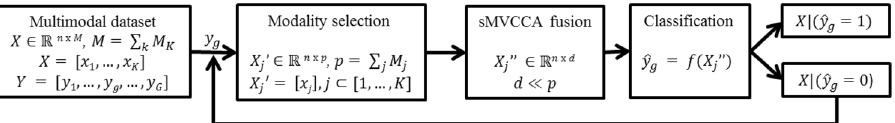
Figure 2. Cascaded multiview canonical correlation analysis (CaMCCo) algorithm for constructing the joint multimodal data fusion and multiclass classification